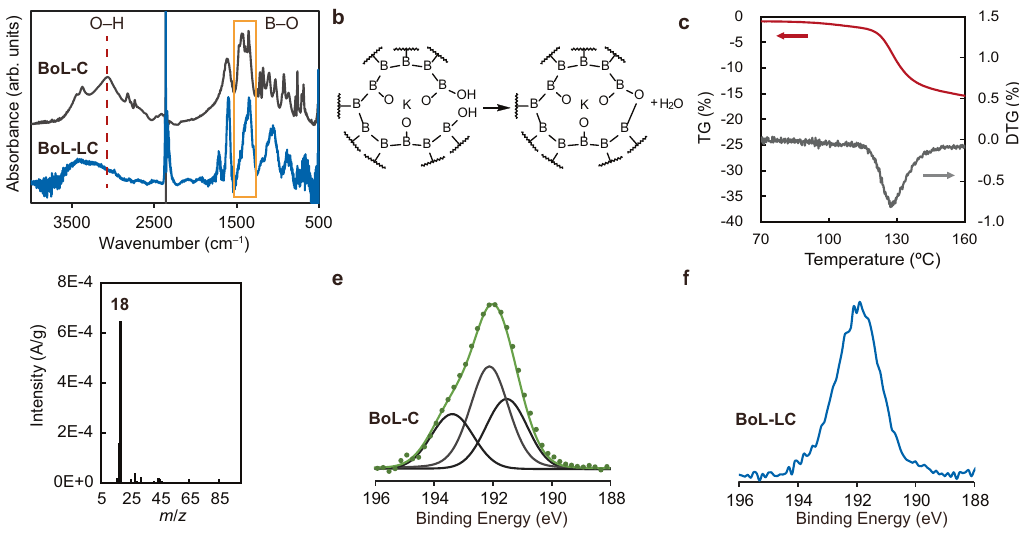
Fig. 2 Chemical change from BoL-C to BoL-LC. a Infrared (IR) spectrum change from BoL-C to BoL-LC. The peak of O – H stretching (red dashed line) was disappeared and the peak shape of the B – O stretching (orange solid line) was changed. Solid line around 2400 cm − 1 is derived from CO 2 gas in the air. b Considerable chemical structure change. Dehydration process from hydroxyl groups on boron (B-OH) to form oxygen bridging structure occurs at the edge parts. The distorted edge structure prevents the 2D layers from crystallization. This change assists the formation of the liquid crystal phase. c Thermogravimetry (TG) and differential thermogravimetry (DTG) spectra of the reaction from BoL-C to BoL-LC. d Mass spectra (MS) at 130 °C of TG-MS measurement. The peak corresponding to H 2 O was observed at the position of m / z = 18. m stands for mass and z stands for charge number of ions. e , f XPS spectra of BoL-C and BoL-LC at B 1 s region,